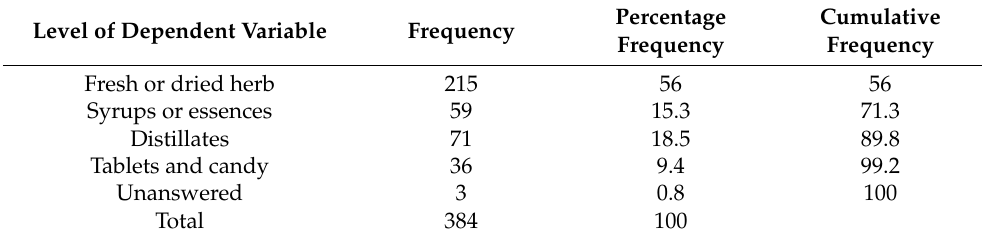
Table 1. Level and frequency of the dependent variable.